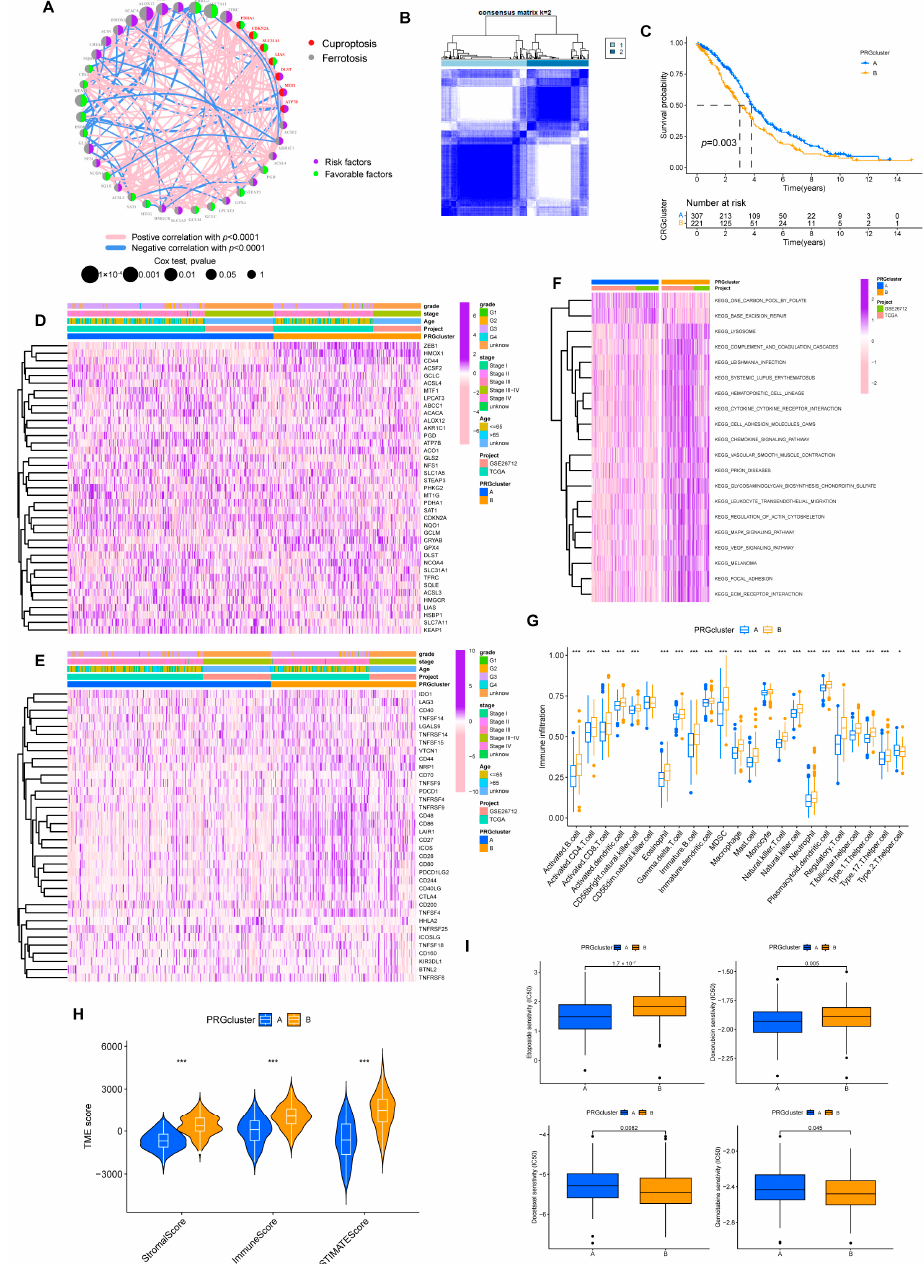
Figure 3. Prognosis subtypes identification. ( A ) Network diagram of 39 PRGs . ( B ) Consensus matrixes for all samples were clustered into specific subtypes (k = 2). ( C ) Prognostic differences between two subtypes. ( D ) Heatmap of the correlation of subtypes with clinical features. ( E ) Heatmap of the correlation of subtypes with ICPs. ( F ) GSVA analysis of two subtypes. ( G ) Overview of immune infiltration between the two subgroups. (* p < 0.05; ** p < 0.01; *** p < 0.001) . ( H ) Different subtypes differ in immune microenvironment scores (stromal and immune scores). (* p < 0.05; ** p < 0.01; *** p < 0.001). ( I ) Sensitivity of subtypes to the chemotherapeutic